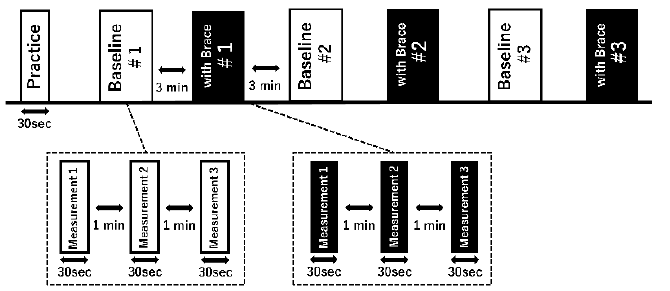
Figure 2. Experimental procedures: one set consisted of three measurements for 30 s and alternately performed with and without the brace, and the first set was randomized with or without brace.